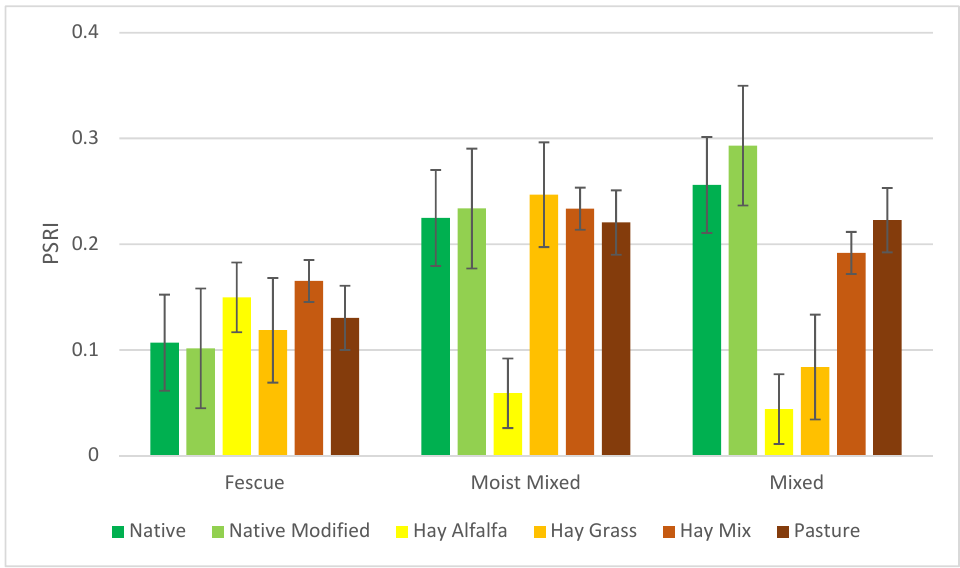
Figure 5. Mean and standard deviation PSRI values for the grassland/forage land classes in the three different ecoregions.